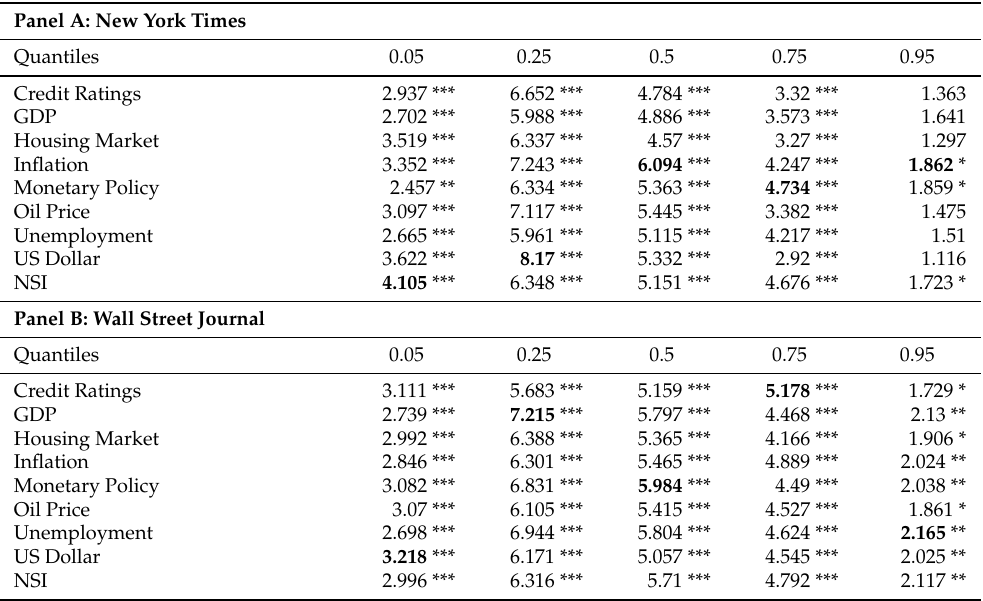
Table A1. Causality-in-quantiles results for daily GARCH-based volatility estimates of South Africa: fundamentals versus sentiment.